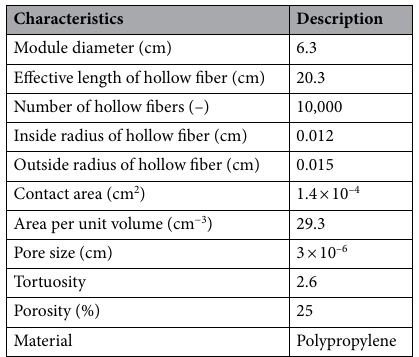
Table 2. Characteristics of the hollow fiber module.